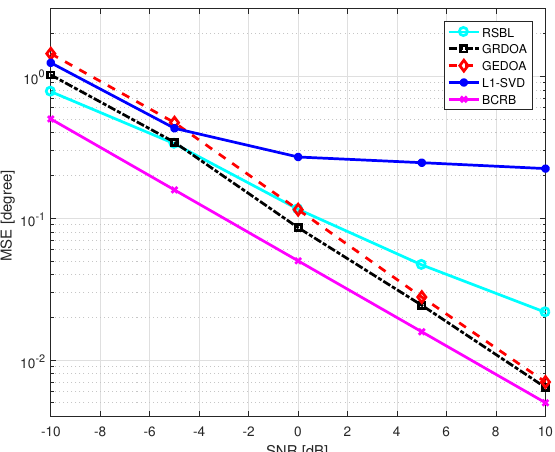
Figure 11. MSE of DOA estimation versus SNR. Two correlated sources uniformly come from intervals of [ − 30 ◦ , − 20 ◦ ] and [ 0 ◦ ,10 ◦ ]